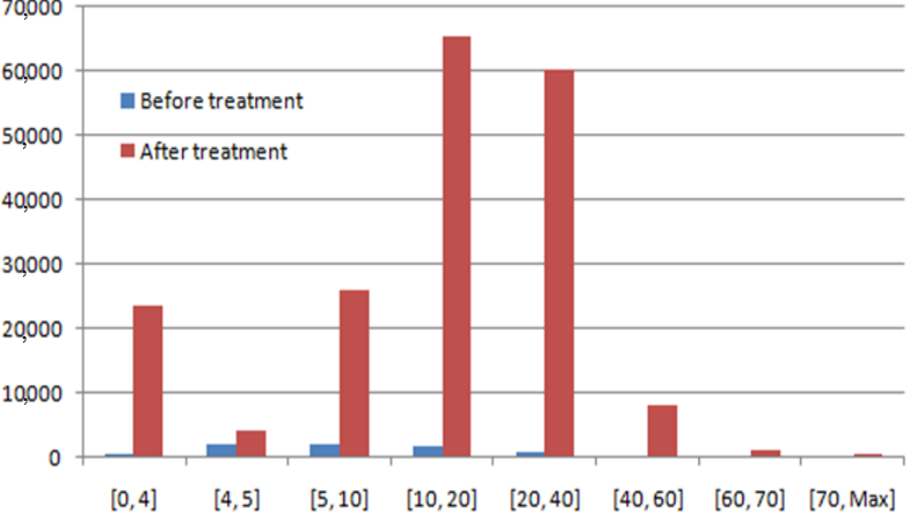
Figure 14. Histogram’s distribution of PDSCH (before and after treatment).